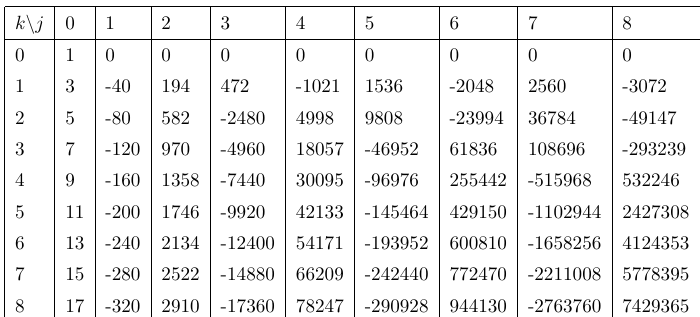
Table 26. Table of b jk coe(cid:14)cients for h SU(2)